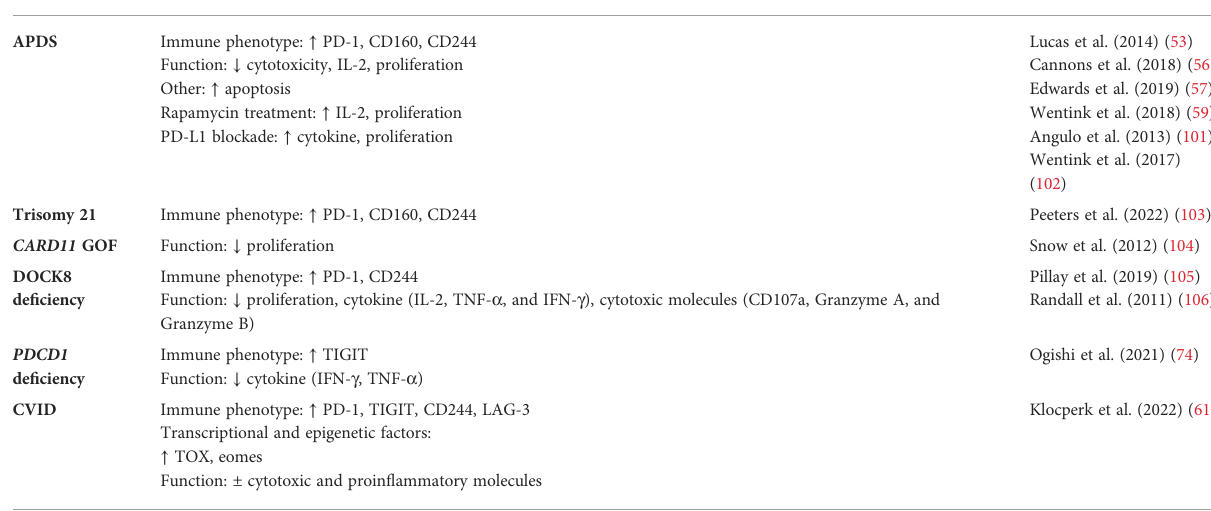
TABLE 1 Summary table of data suggesting T-cell exhaustion in various